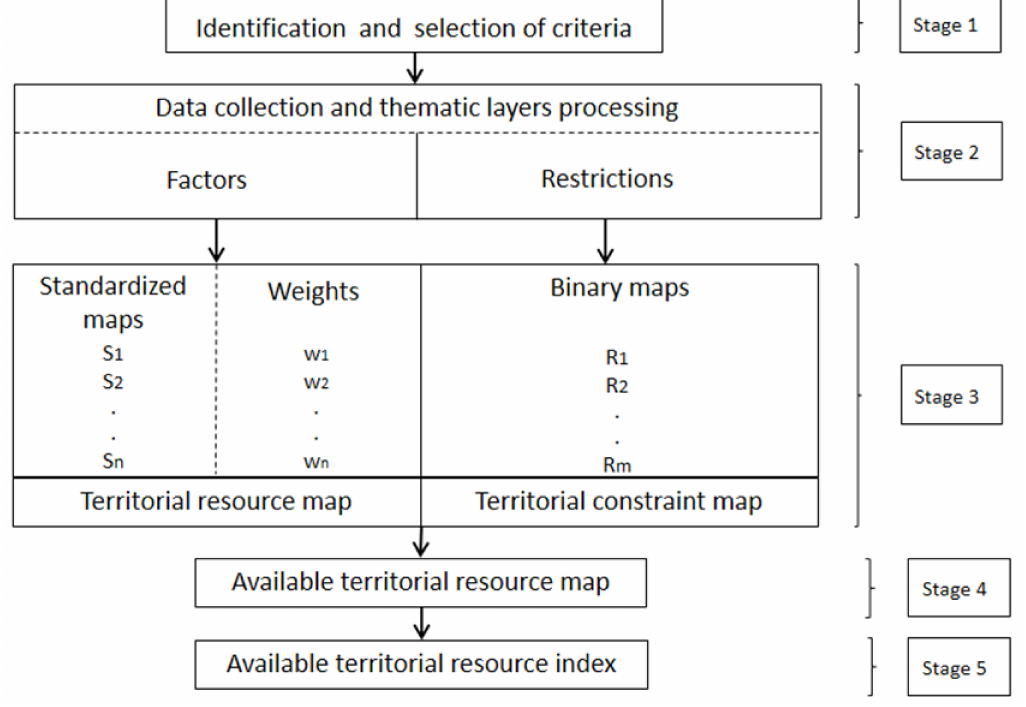
Figure 2. Methodology for available territorial resource map and